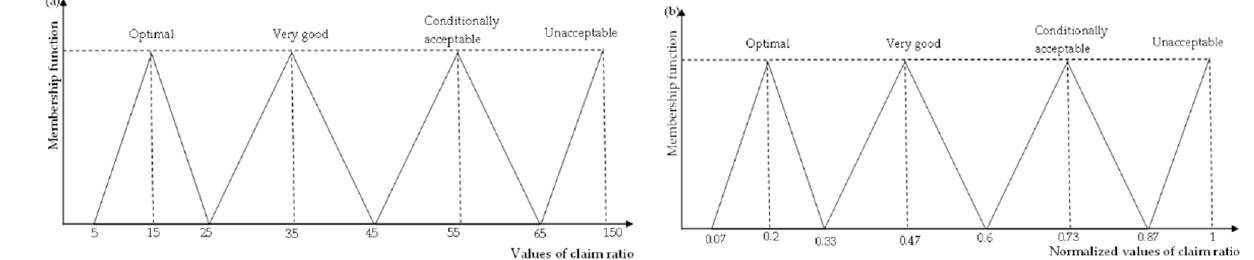
Figure 6. Linguistic forms for describing ( a ) claim ratio and ( b ) corresponding the normalized TFNs.